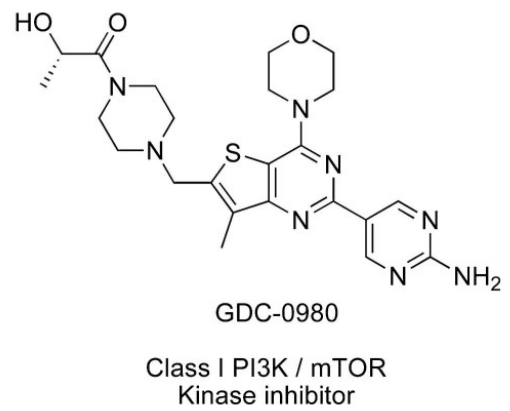
Figure 2. Structure of Apitolisib (GDC-0980), morpholino thienopyrimidine inhibitor of class I PI3K and mTOR kinase in the PI3K/mTOR signalling pathway [12]. (http://creativecommons.org/publicdomain/ zero/1.0/).